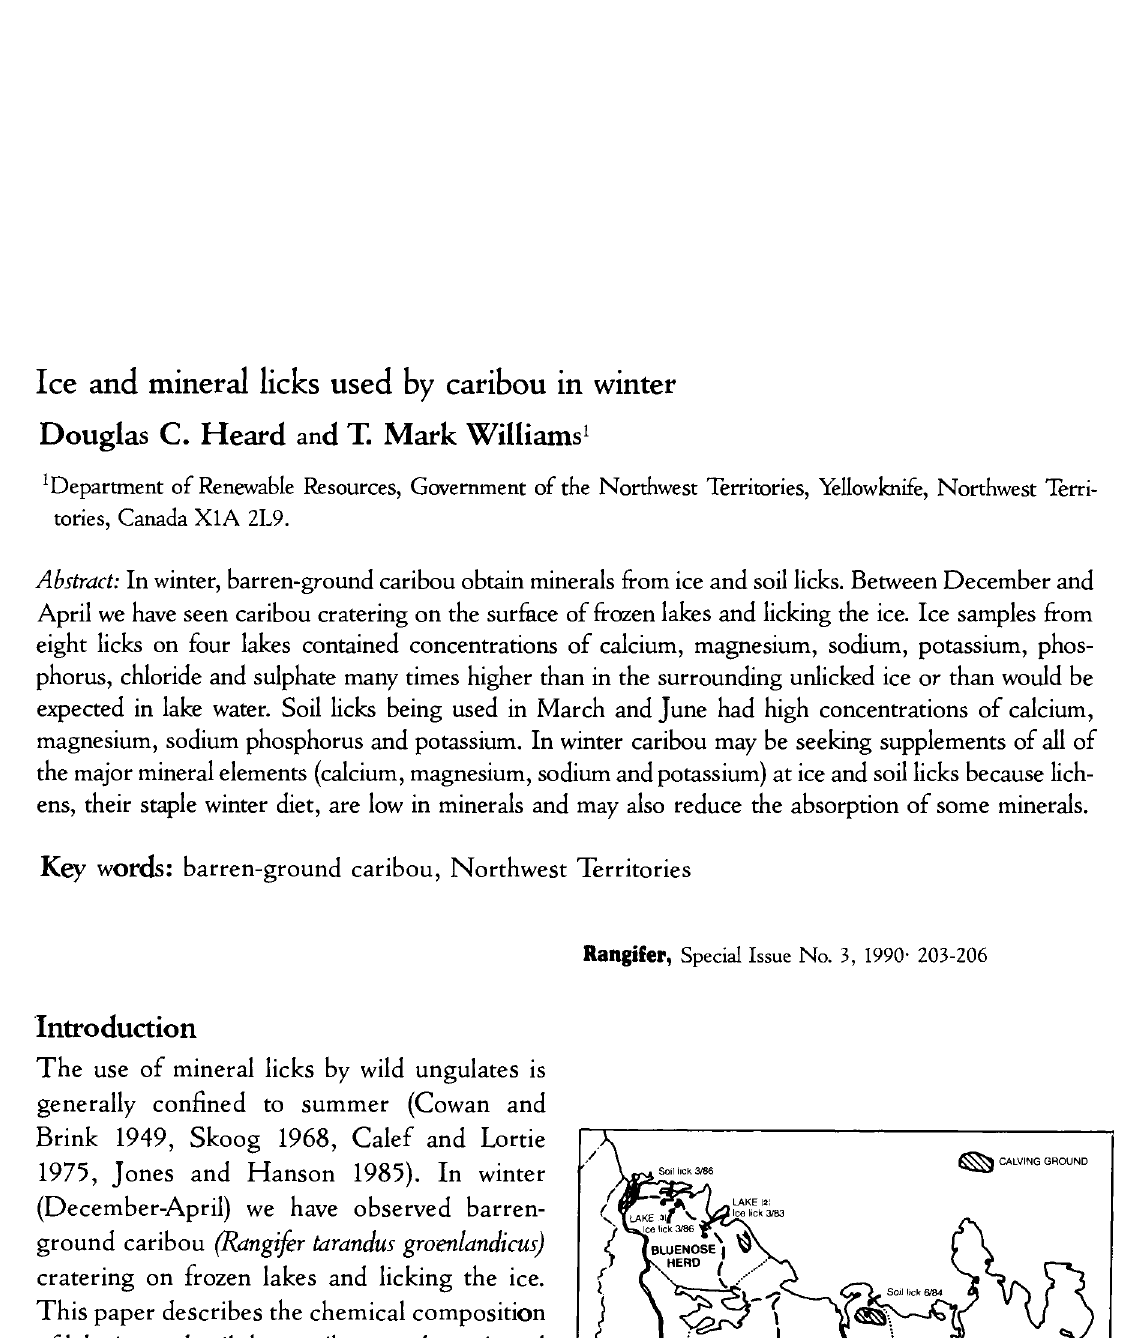
Figure l.The location of ice and soil mineral licks sampled on barren ground caribou winter